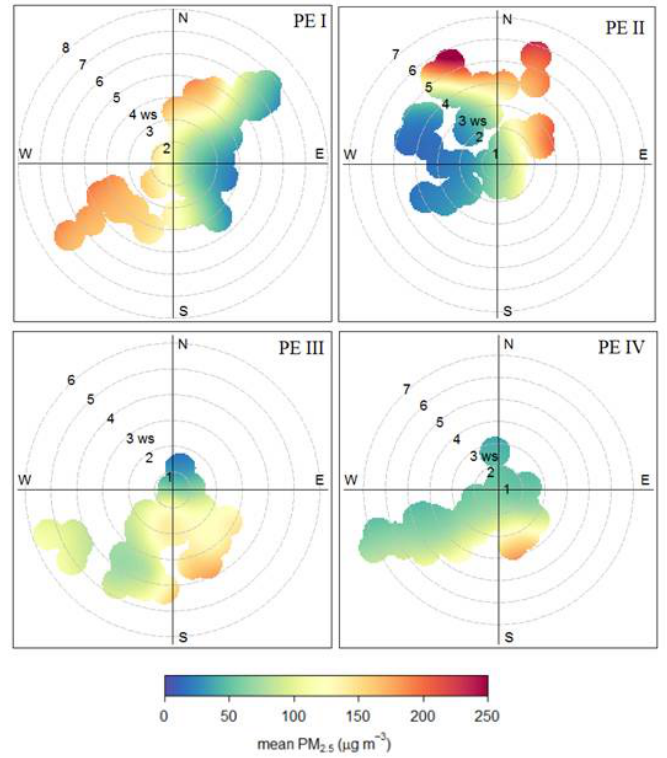
Figure 9. Bivariate polar plots of PM 2.5 during, and for several hours before and after, PEs, based on urban ground-monitoring data of hourly PM 2.5 concentration, wind speed, and wind